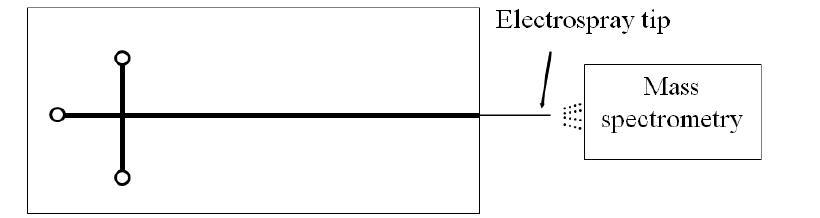
Figure 8. Schematic illustration of a CE chip with electrospray mass